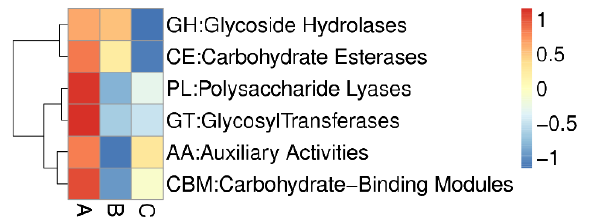
Figure 1. Comparative CAZy families heatmap of the suancai samples at three time points.